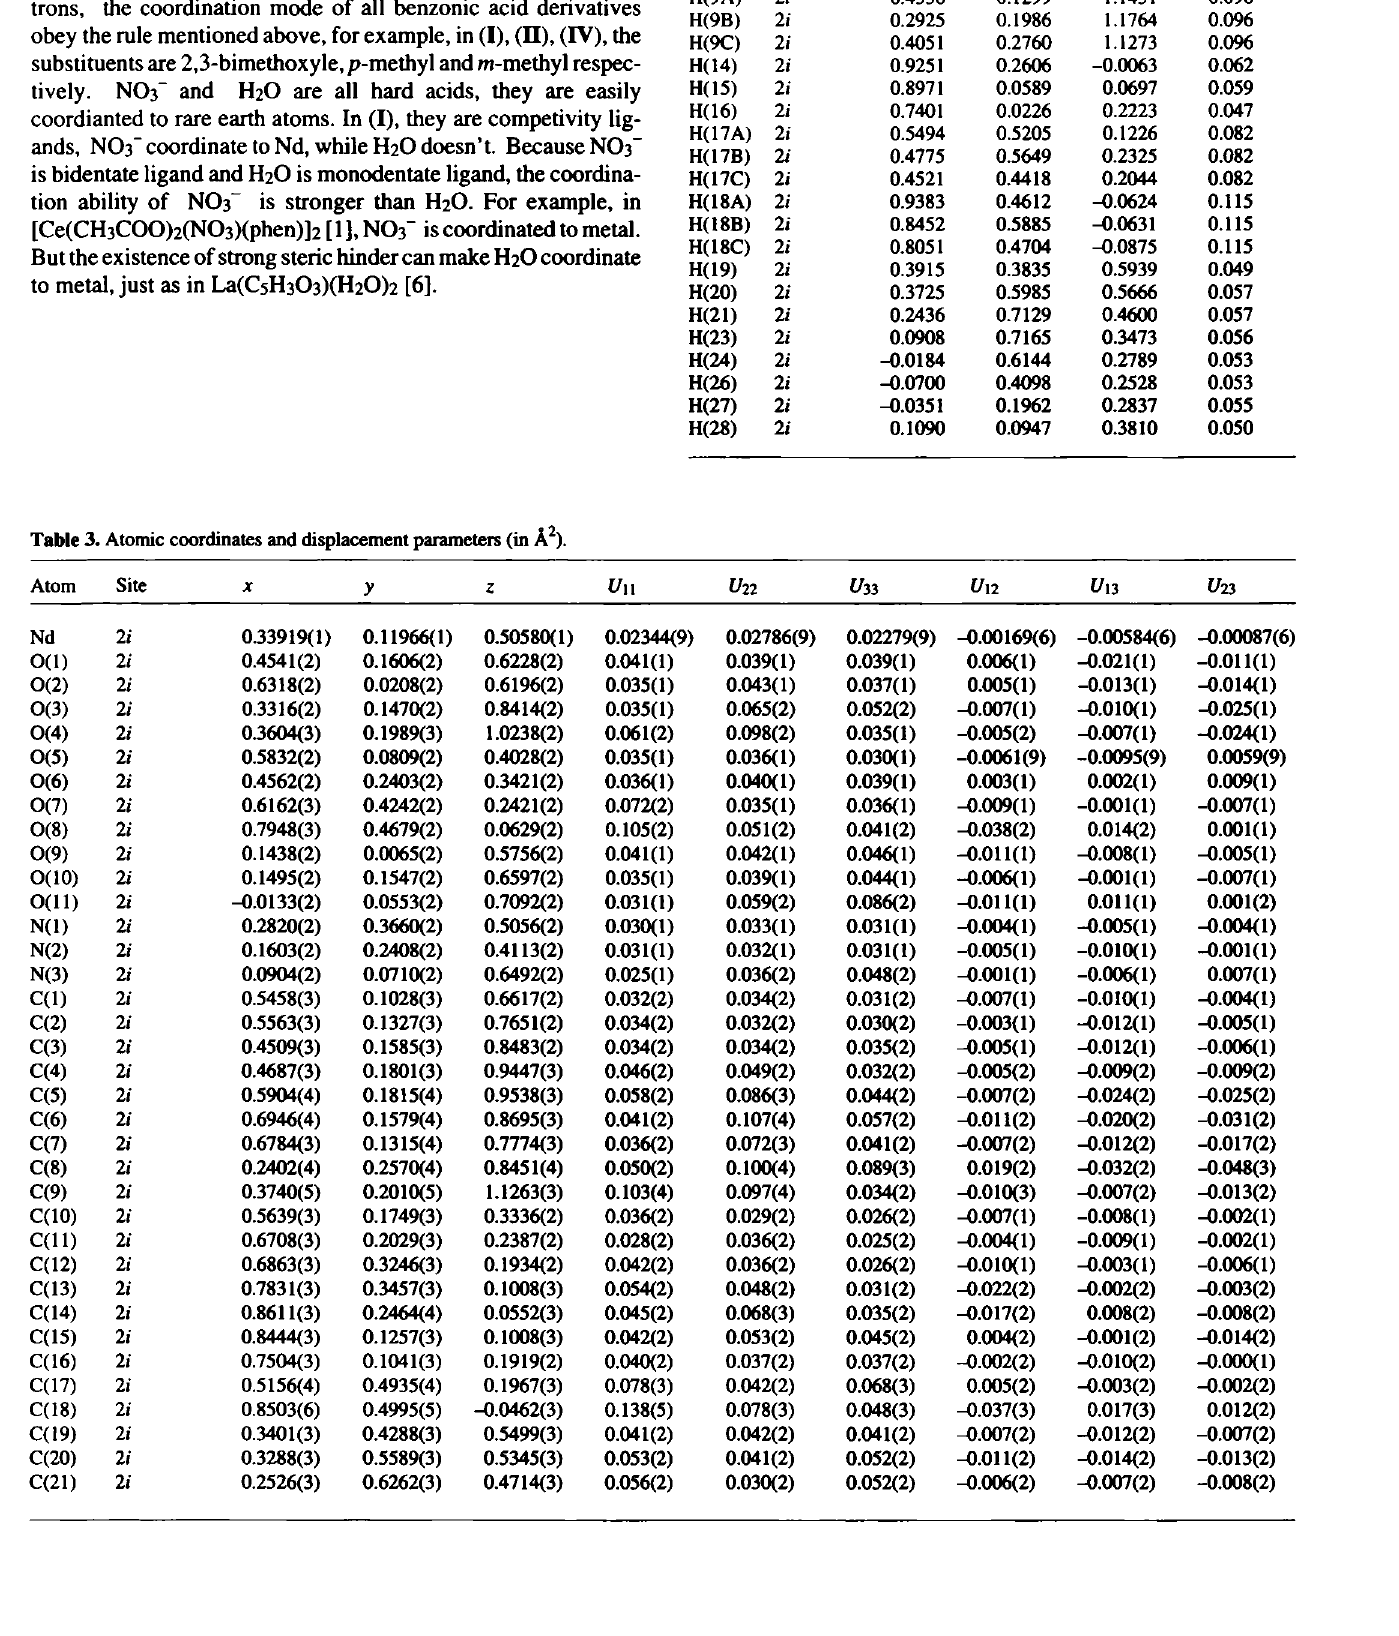
Table 3. Atomic coordinates and displacement parameters (in Â 2